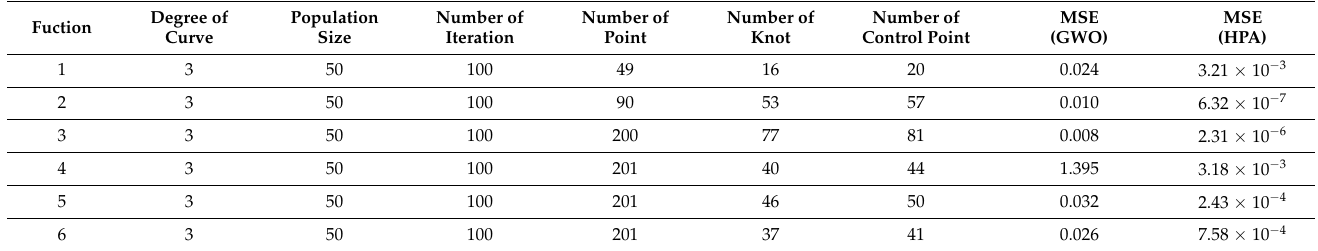
Table 4. Existing fitting methods based on optimization algorithm and their fitting results. (‘ × ’ means that the method can not fit the function f 4